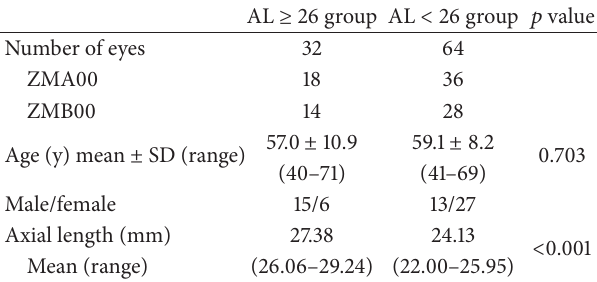
Table 1: Demographic and clinical characteristics of patients strati- fied into axial length of 26 or above (AL ≥ 26 group) and axial length below 26mm (AL < 26